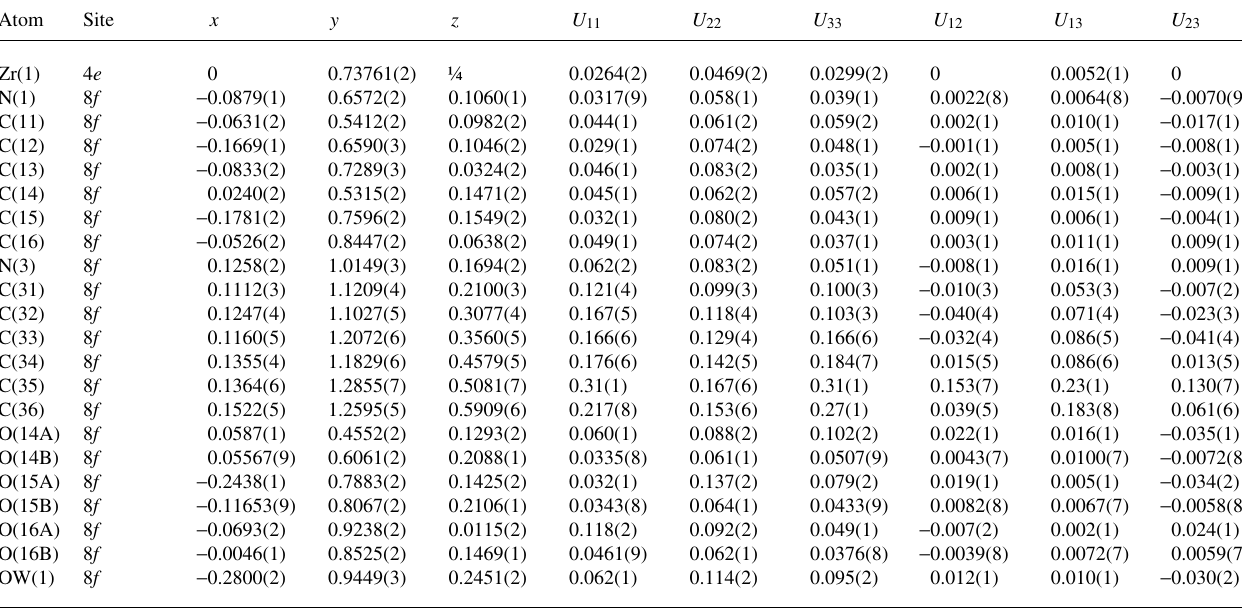
Table 3. Atomic coordinates and displacement parameters (in Å 2 ) .